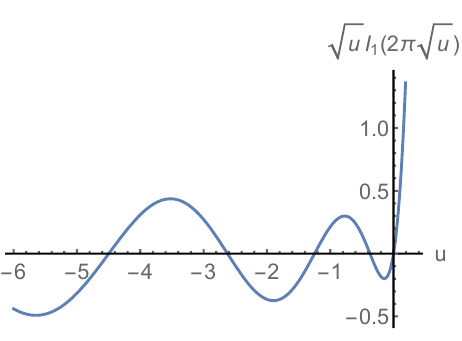
√ √ uI 1 (2 π u ) as a function of u